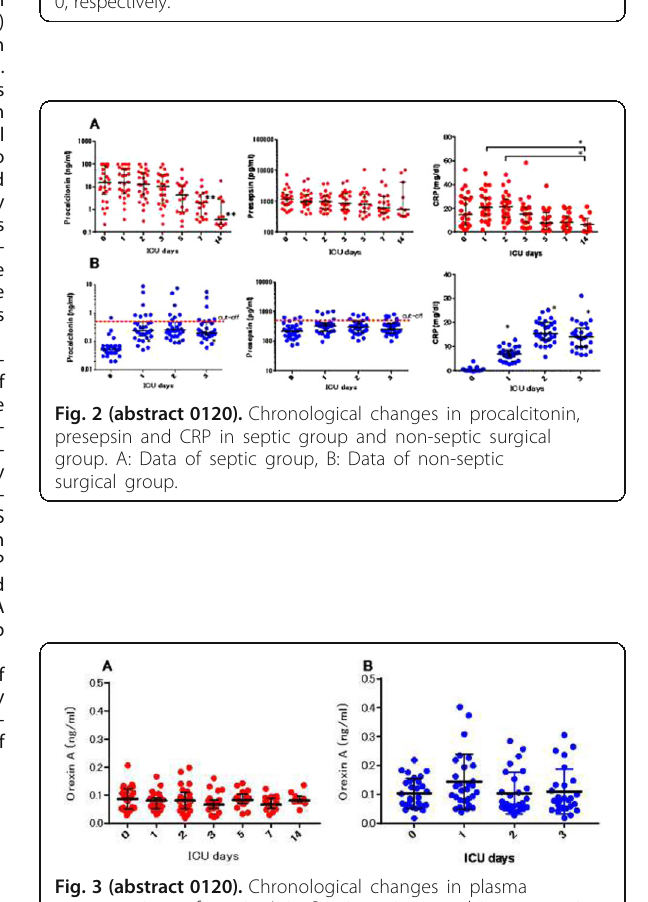
Fig. 1 (abstract 0120). Comaparison of plasma concentrations of orexin A among three groups. Data of non-septic surgical group and septic group were those before the operation and on ICU day 0, respectively.